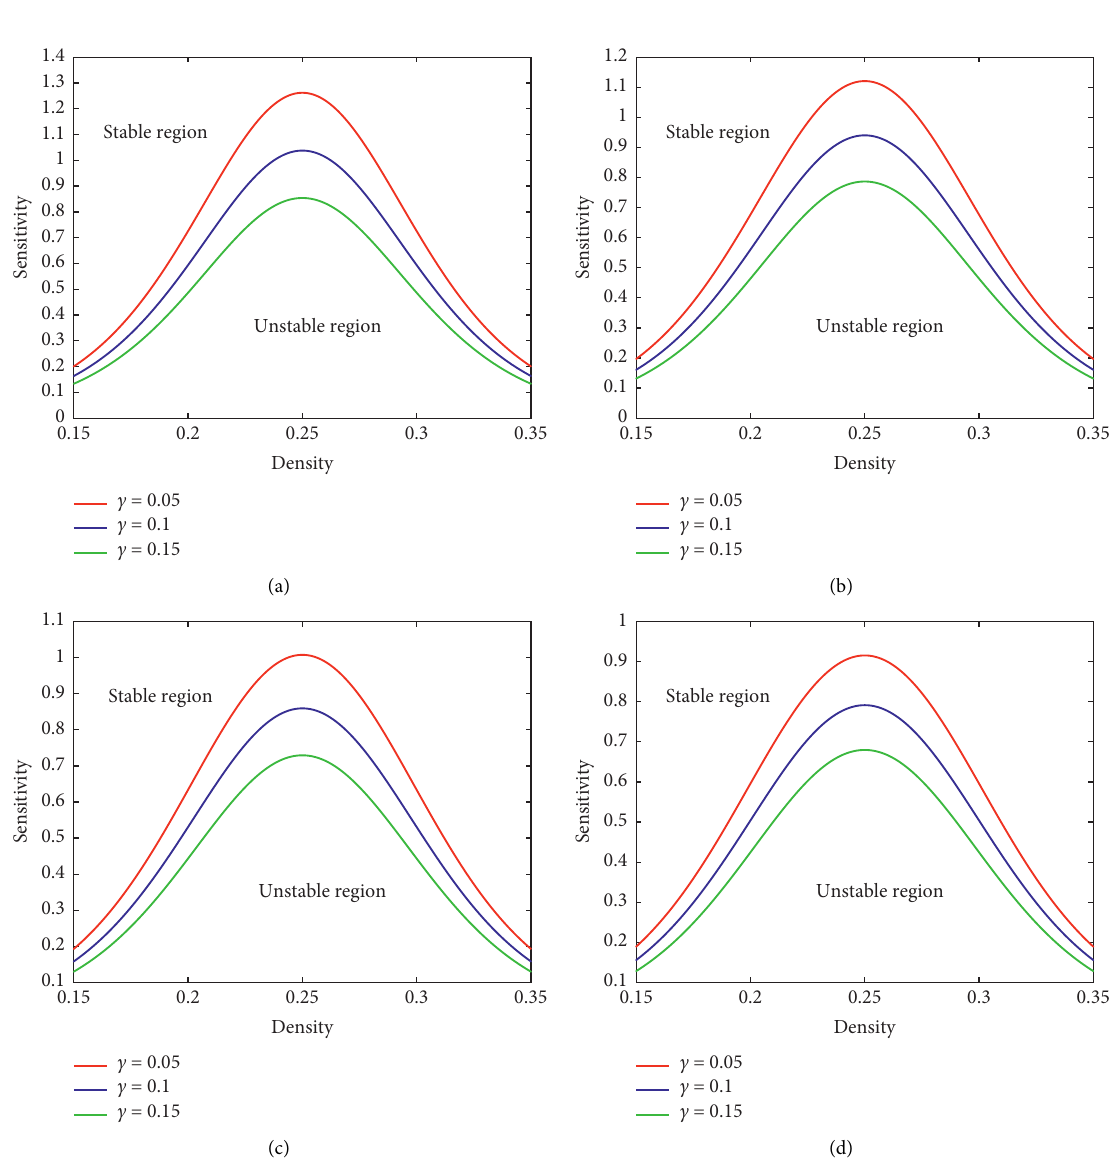
Figure 2: The neutral stability curves for p � 0 . 1 for different values of τ and c : (a) τ � 0 . 5; (b) τ � 1 . 5; (c) τ � 2 . 5; (d) τ � 3 .